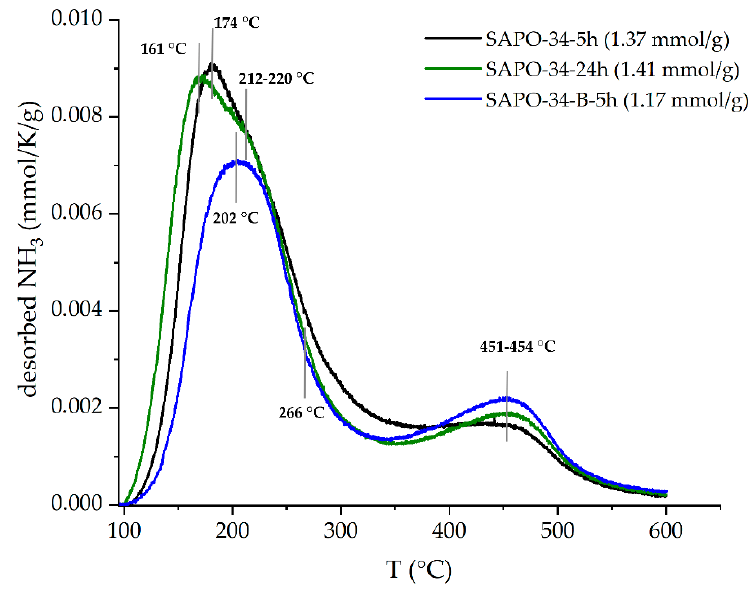
Figure 8. Ammonia TPD curves of SAPO-34.